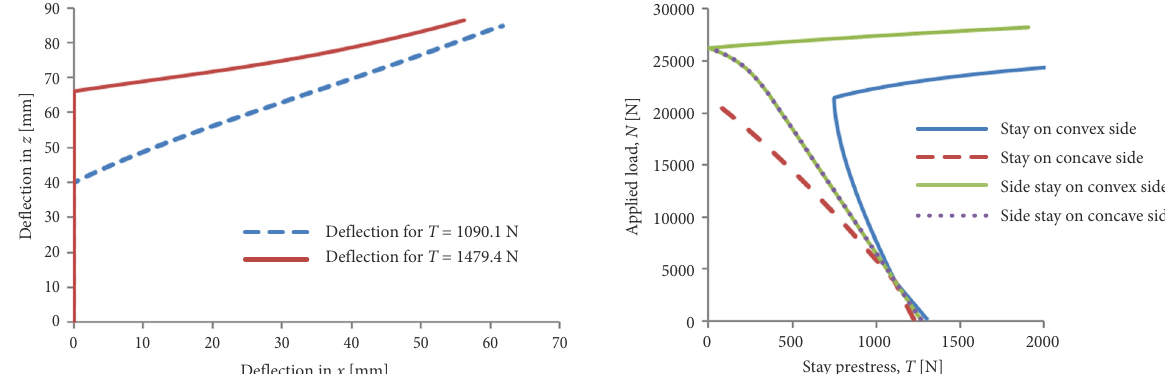
0102030405060708090 Deflection for T = 1090.1 N Fig. 6. The space buckling of initially symmetrically deflected column ( w and loss of prestress in the stays for fixed and sliding stays (middle), for sliding stays N Fig. 7. Sliding saddle FE modeling (left), N cr,sym Fig. 8. Stress-strain relationship for austenitic steel 1.4301 (left), results of GNIA and GMNIA